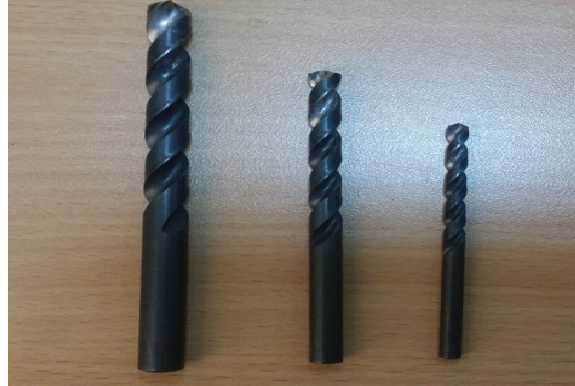
Fig. 4. Twist HSS Drill with Diameters (6, 8, and 10) mm.